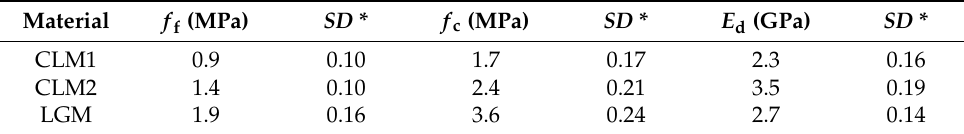
Table 5. The mechanical and thermal properties of the hardened plasters.